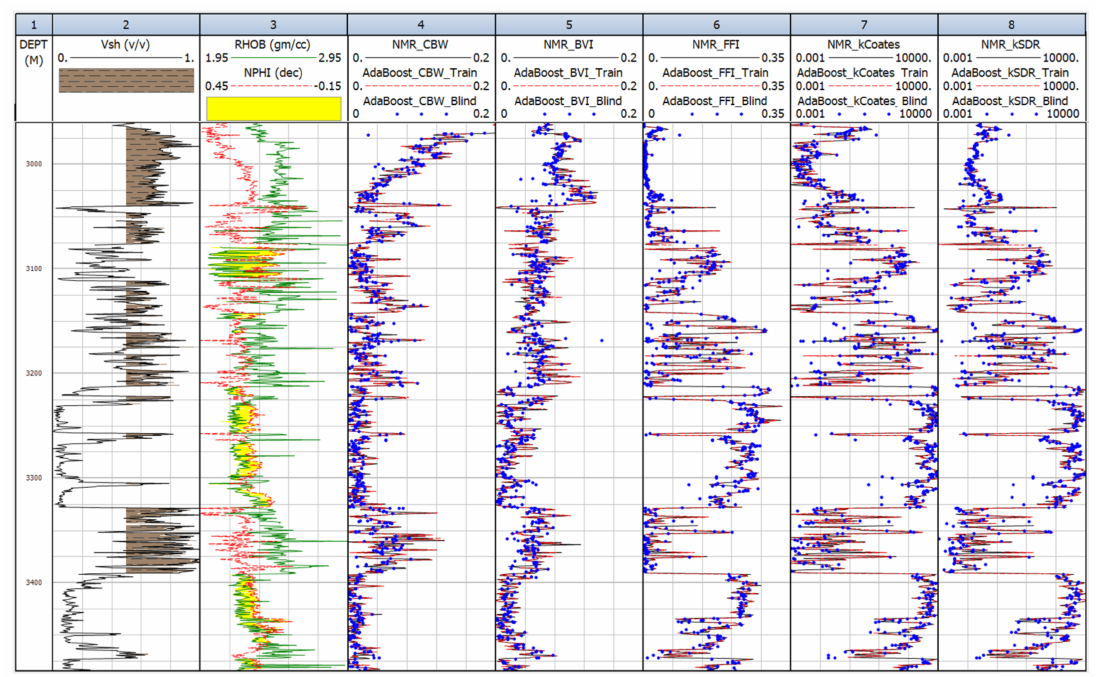
Figure 10. Real and predicted NMR log outputs for Pluto 3ST1, Northern Carnarvon Basin. Track 2 shows Vsh calculated from GR, and Track 3 displays density and neutron logs shaded yellow for sandstone lithology. Tracks 4 to 8 show real NMR log outputs (grey curves), AdaBoost predicted on training (red dashed lines), and AdaBoost predicted on randomly chosen blind datasets (blue dots). Real NMR log and AdaBoost predicted outputs on Training dataset overlie each other and AdaBoost predicted outputs on blind dataset closely follow the trends but with minor misprediction for some of the data